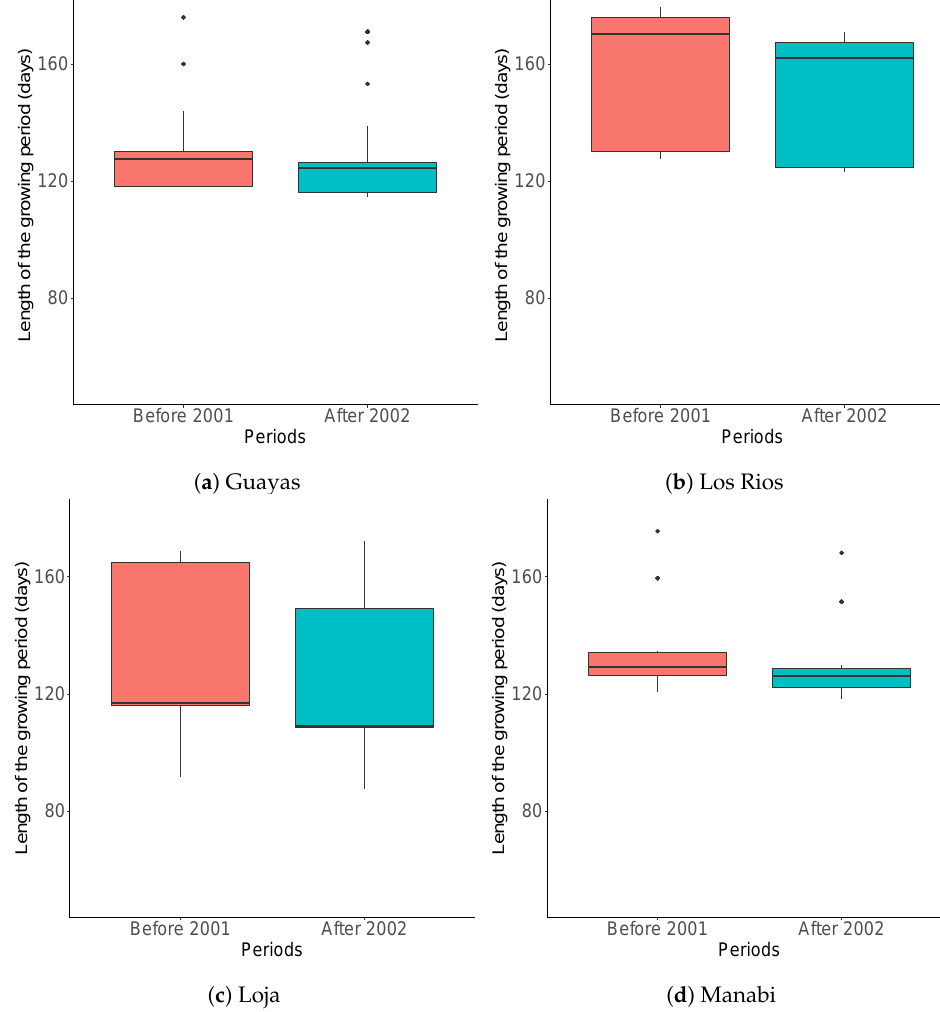
Figure 8. Boxplot of the simulated length of crop growing period (days)—period from sowing to maturity—of each simulation unit in ( a ) Guayas, ( b ) Los Rios, ( c ) Loja and ( d ) Manabi. The red column shows the average from 1984 to 2001 of each simulation unit and the green column shows the average from 2002 to 2019 of each simulation unit for ( a ) Guayas, ( b ) Los Rios, ( c ) Loja and ( d )